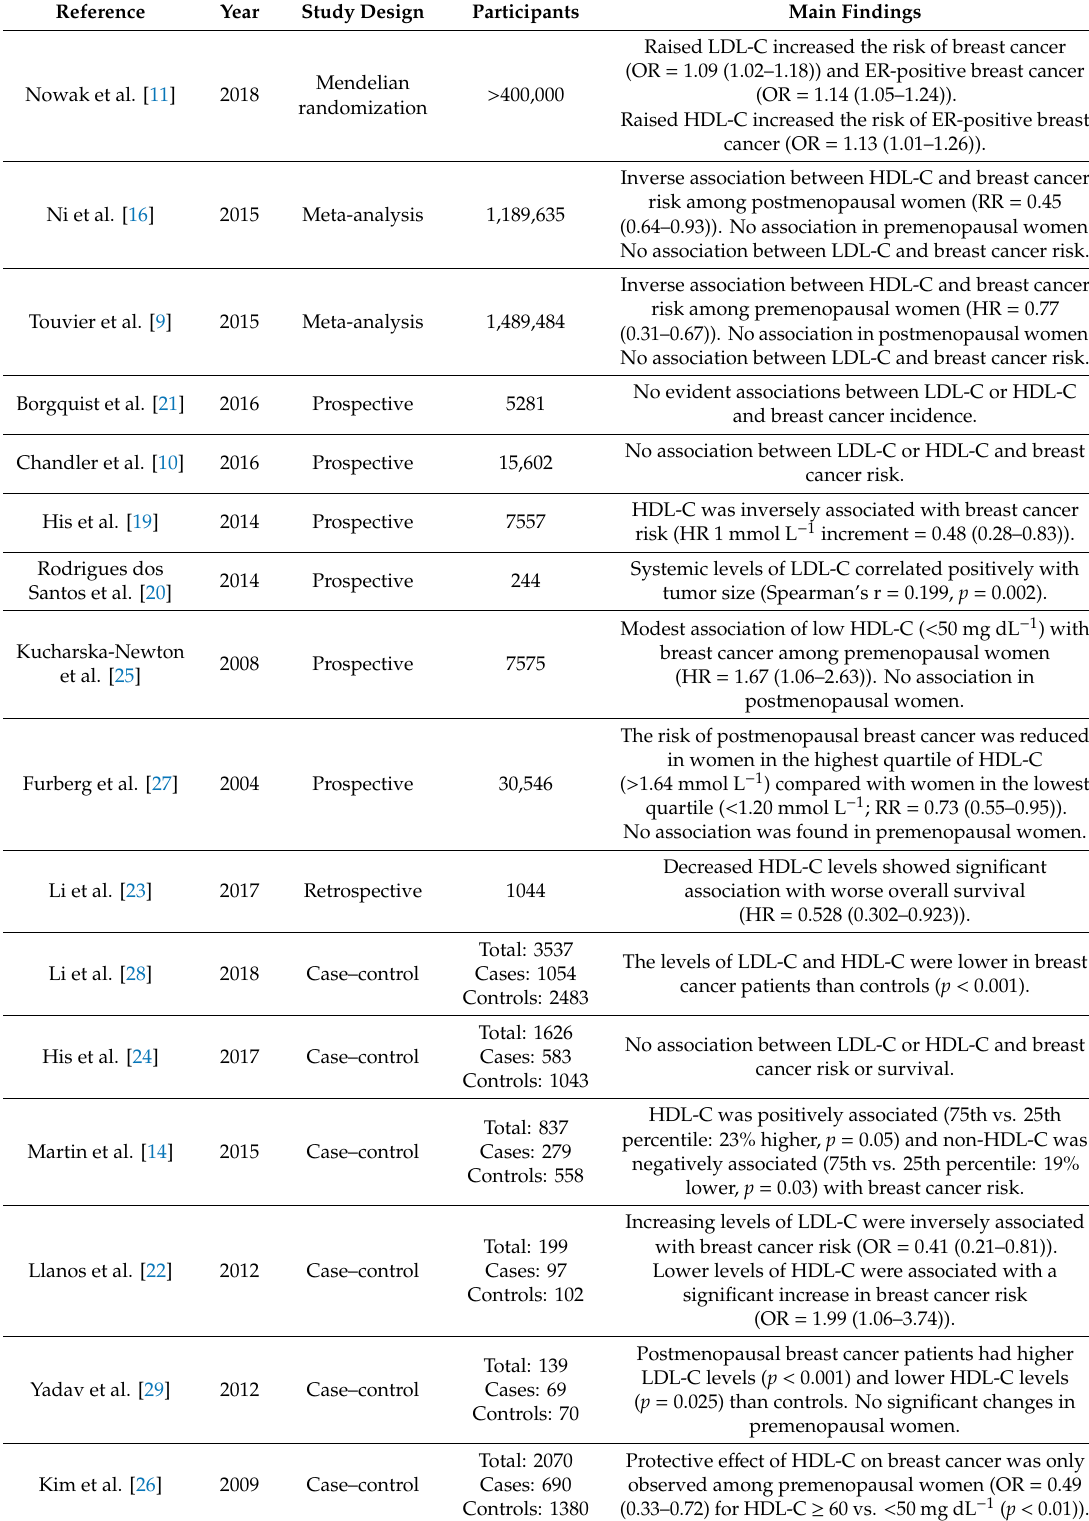
Table 1. Clinical and epidemiological studies linking low-density lipoprotein cholesterol (LDL-C) and high-density lipoprotein cholesterol (HDL-C) levels to breast cancer